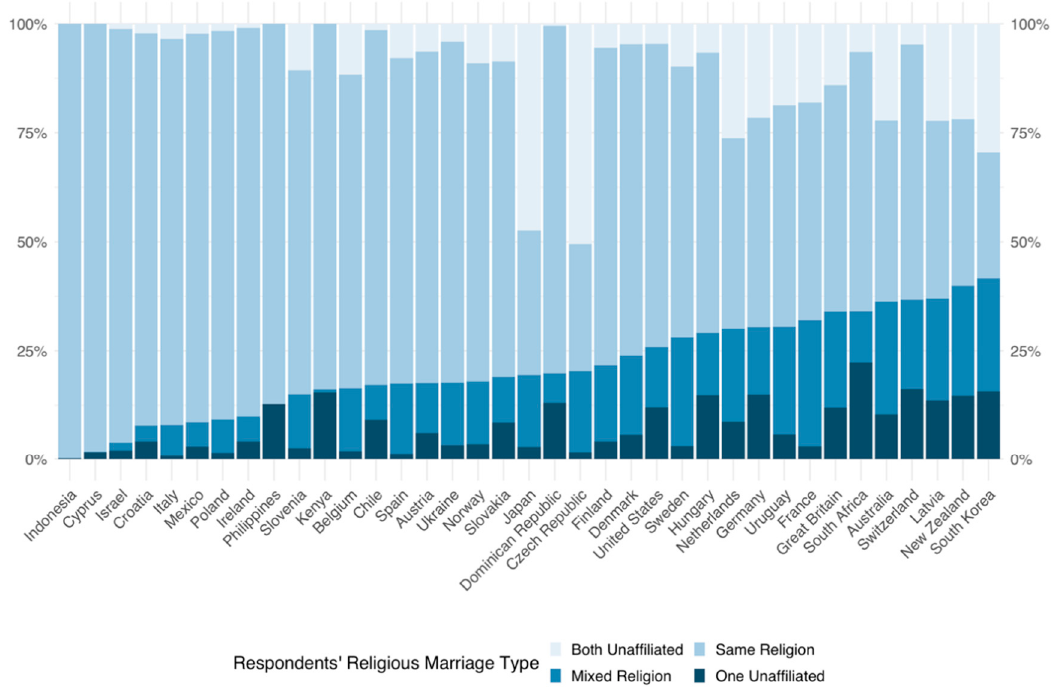
Figure 1. Percent religious heterogamy by country, ISSP 2008.